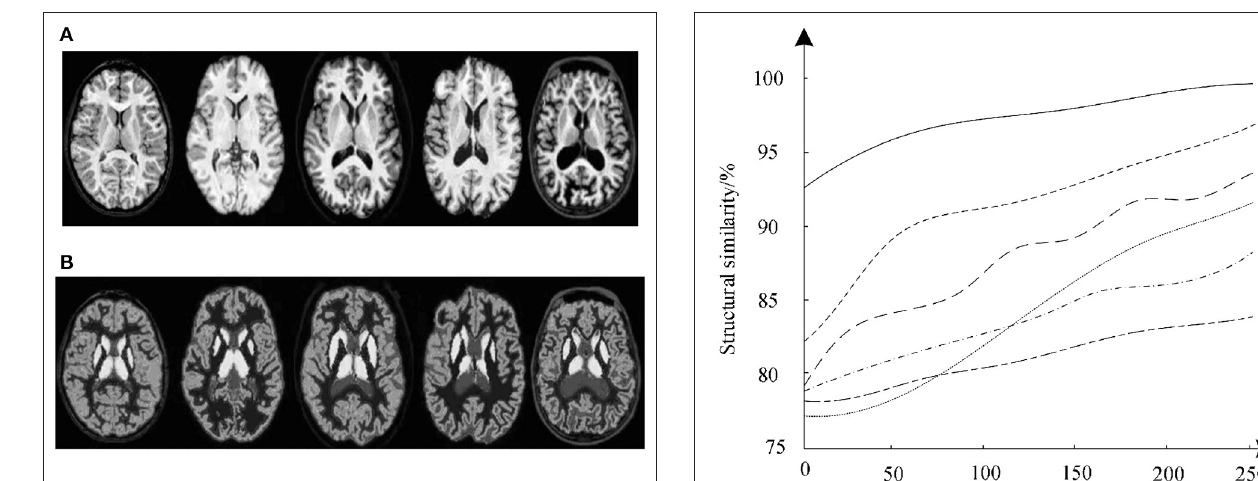
FIGURE 2 | Comparison of the effect of brain image segmentation before and after. (A) Presegmentation brain images. (B) Brain images postsegmentation by proposed algorithm.